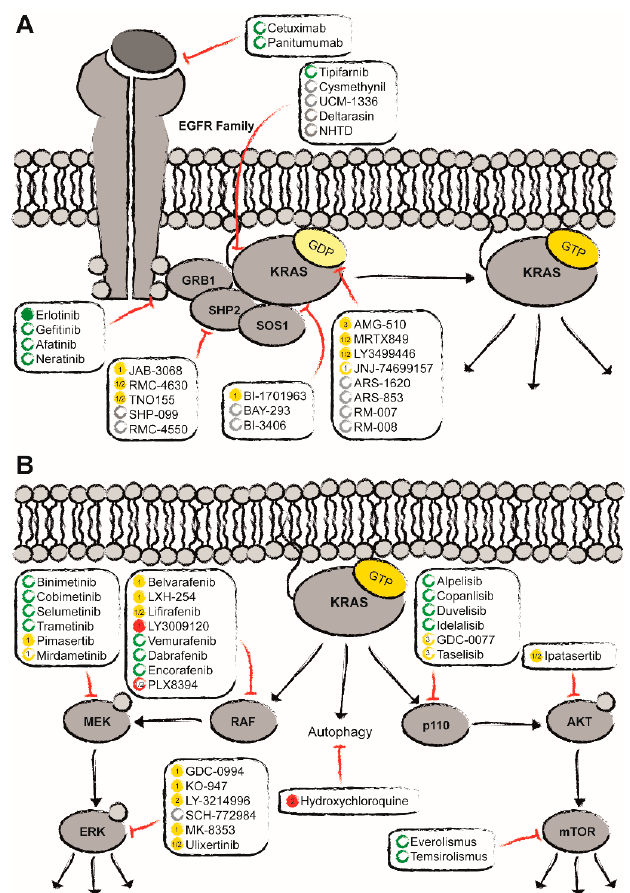
Figure 1. Clinical status quo of the potential treatment options for KRAS mut pancreatic ductal adenocarcinoma (PDAC) (adapted from Moore et al.) [58]. Apart from the direct targeting of KRAS mut with covalent allele-specific inhibitors as well as farnesylation inhibitors ( A ), indirect inhibition has gained more and more momentum ( B ). Here, approved drugs are depicted in green, ongoing clinical trials in yellow, and in red compounds that have failed to show benefit in clinical studies. Promising preclinical candidates are marked in grey. Empty circles represent the status of compounds that have not been approved or tested in PDAC. Filled circles indicate that these compounds have explicitly been approved for PDAC or tested at least in (advanced) solid tumors including PDAC.